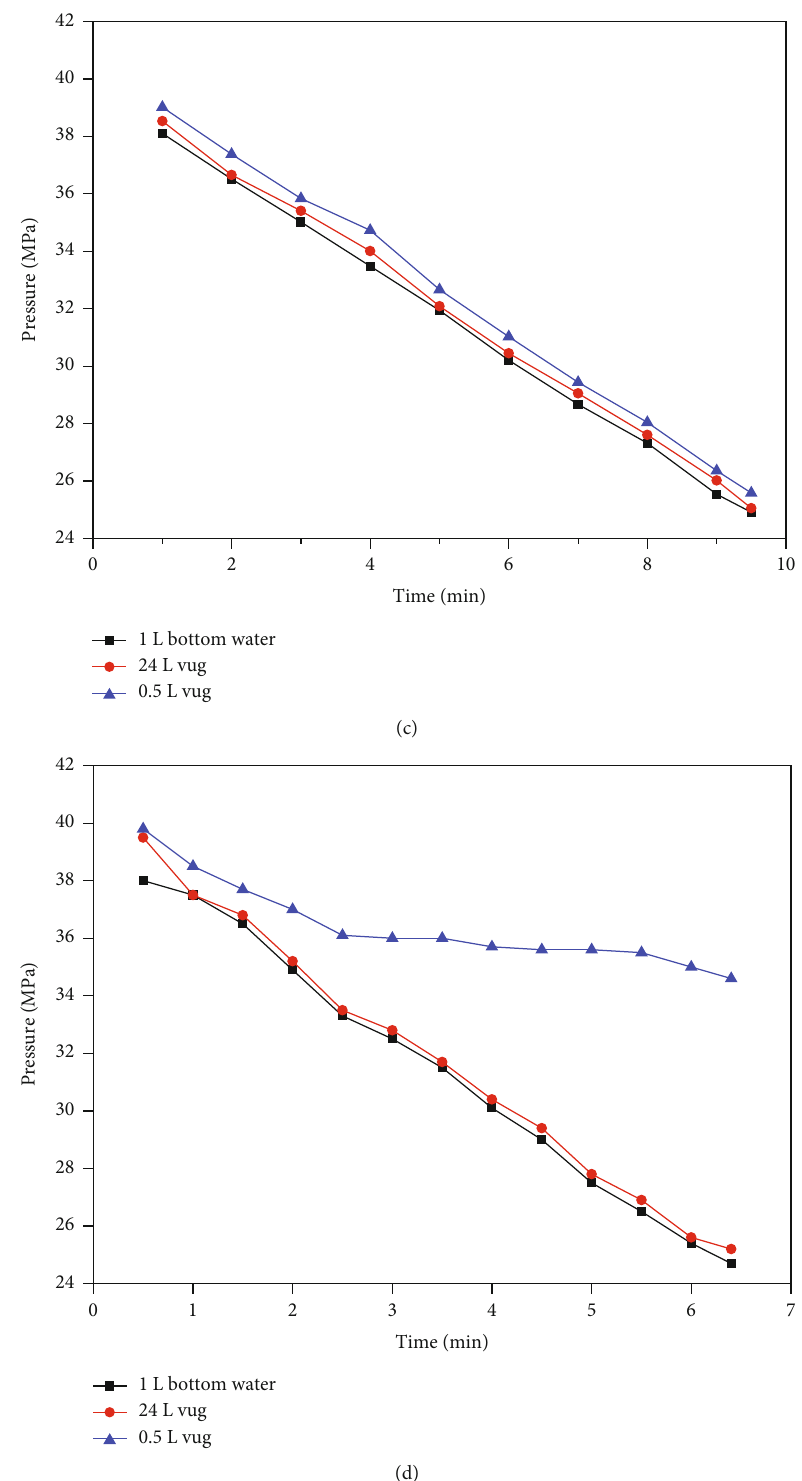
Figure 3: Pressure variation curves in high-pressure physical property experiments under connection type I (di ff erent production rates with (a) 1mL/min, (b) 10 mL/min, (c) 20 mL/min, and (d) 30